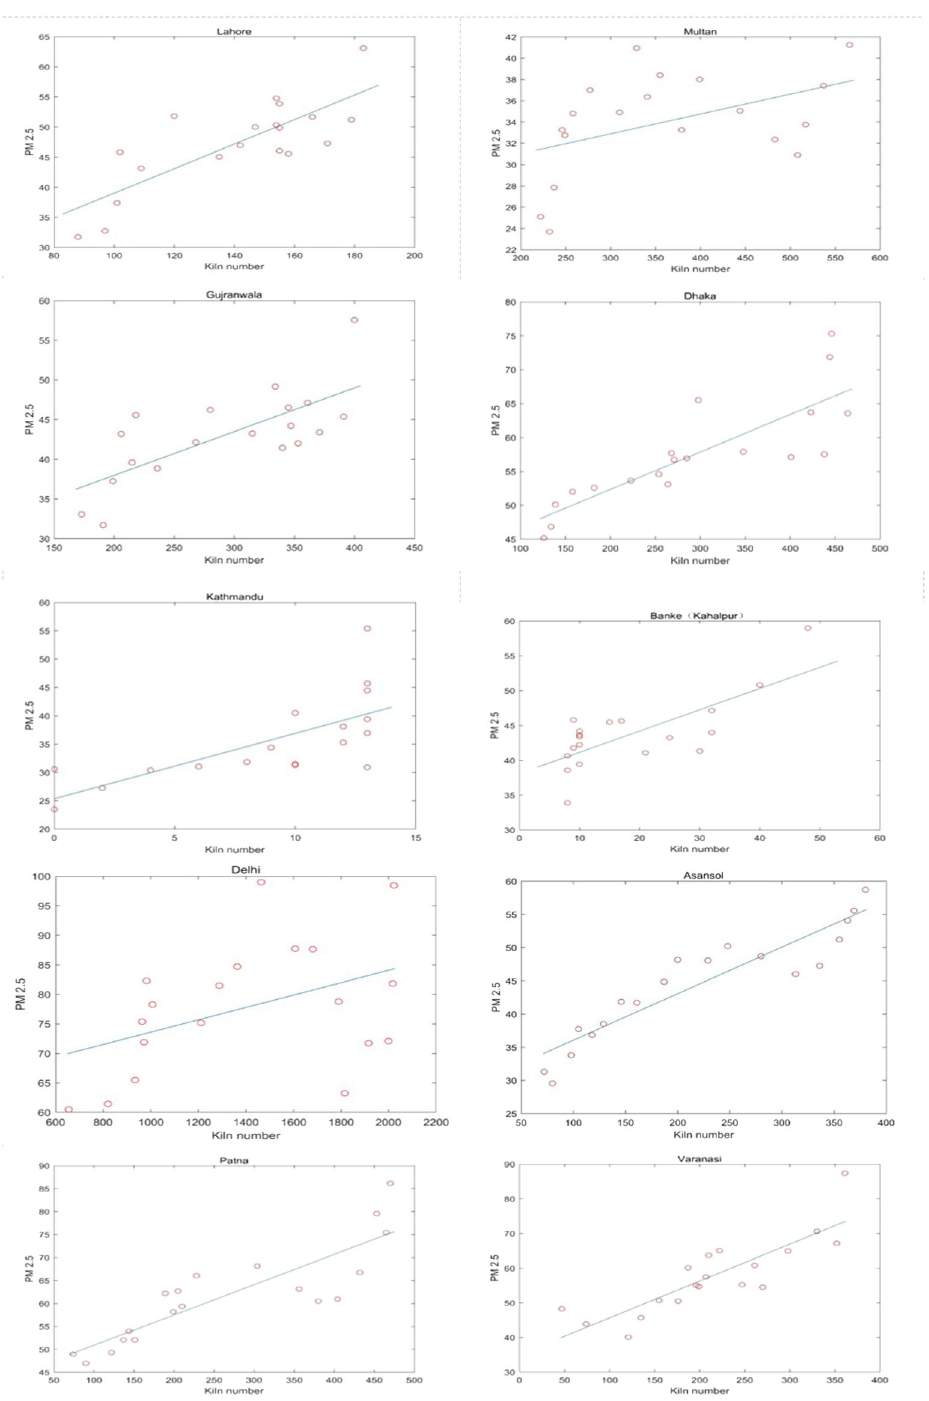
Fig. 8 PM 2.5 concentration vs. Kiln number for those urban areas having the largest number of kilns across the four countries of study. For each of these areas, the city boundaries as determined by GADM data (version 3.6) which maps the administrative areas of all countries, at all levels of sub- division (https://gadm.org/download_country_v3.html) were used to determine the number of kilns present for the period 1998 – 2016, and this was plotted against the spatially corresponding annual concentrations of PM2.5 ( μ g/m 3